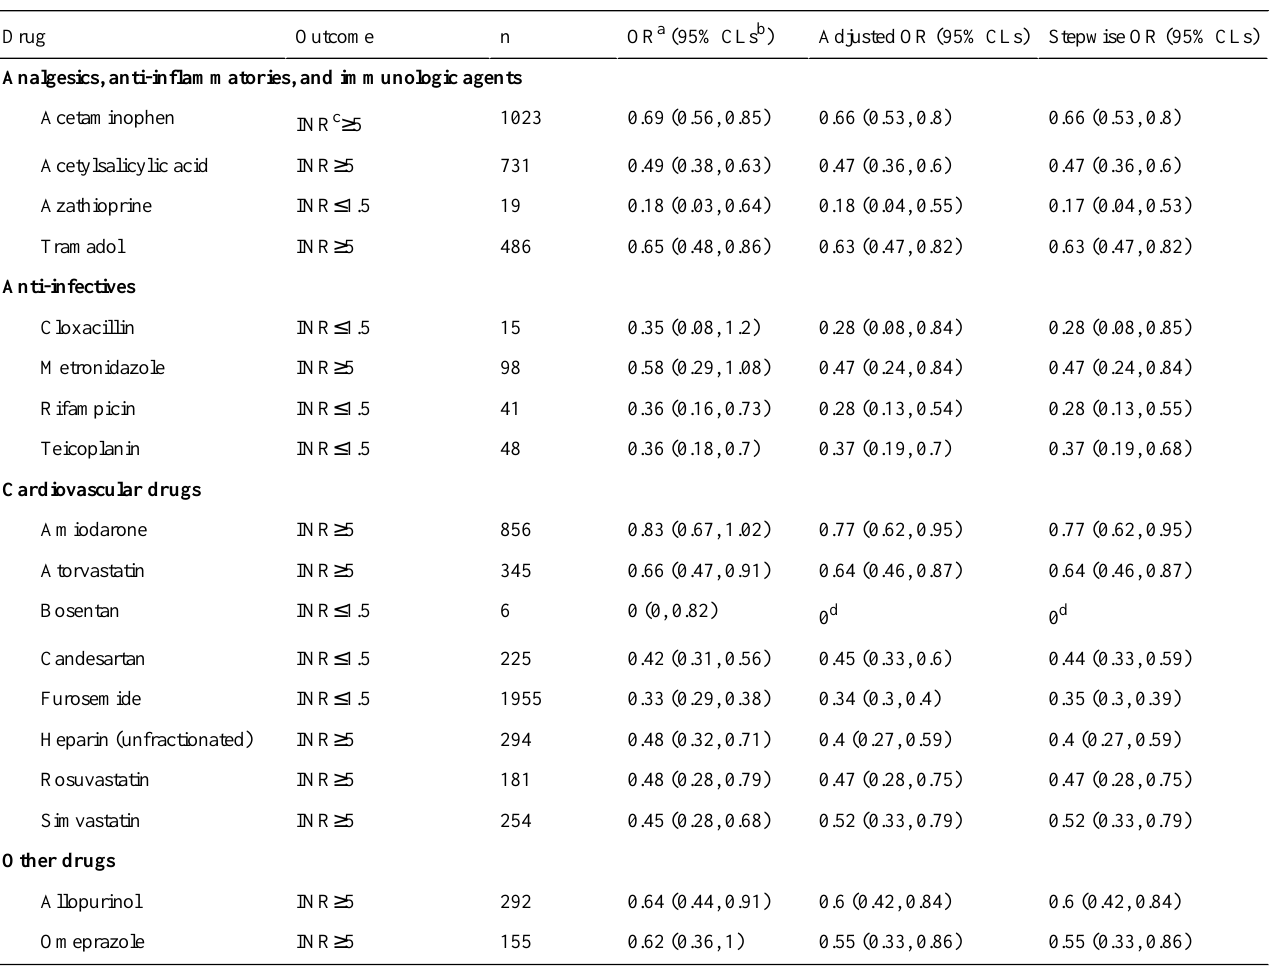
Table 1. Drugs interacting with VKAs upon initiation and that had at least one significant OR (in all cases, 4047 stays are analyzed).